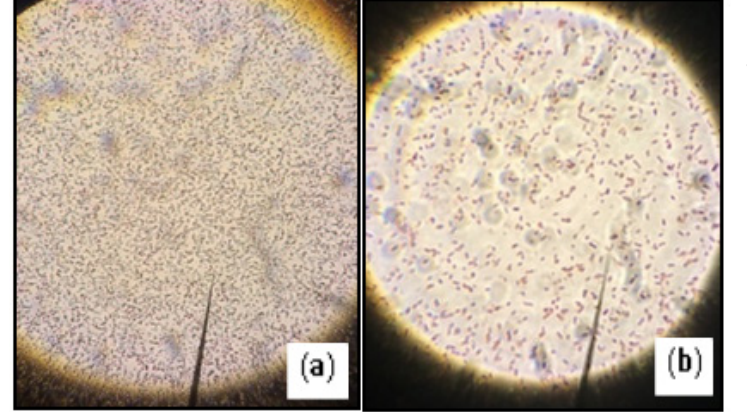
Figure 4. Microbial load on grape sample before (a) after (b) freeze dried process 40 X and 100 X